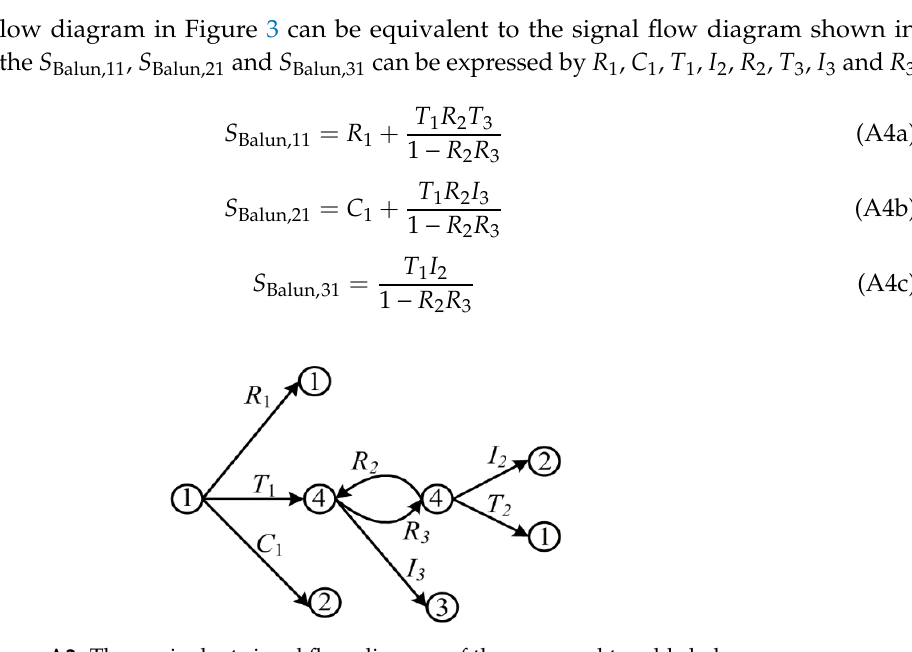
Figure A2. The equivalent signal flow diagram of the proposed tunable balun.